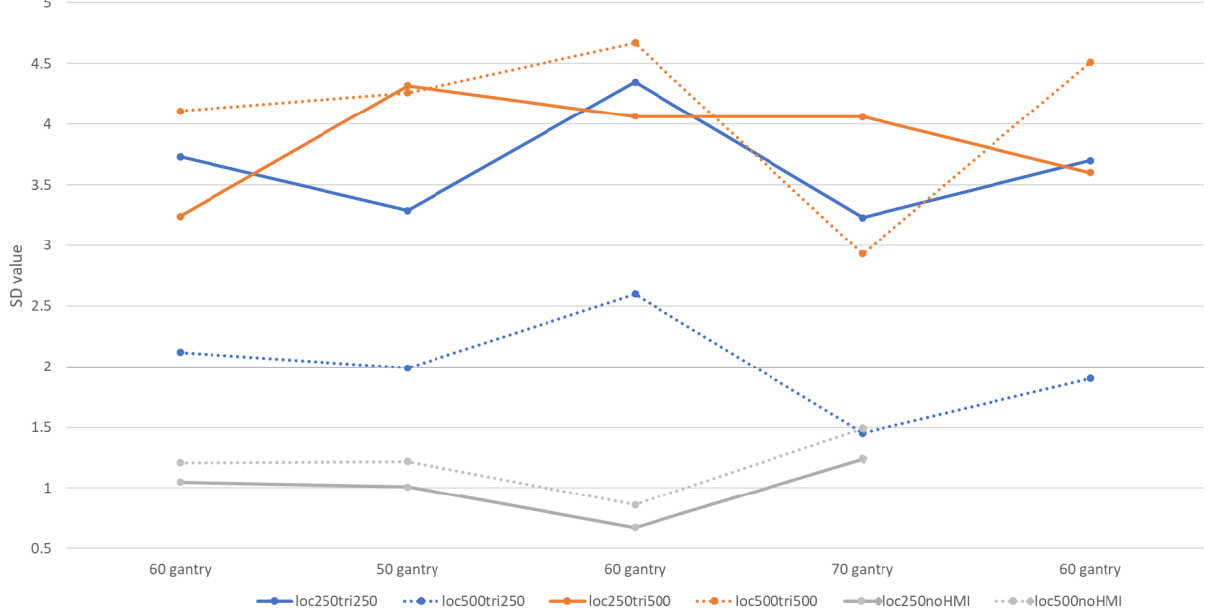
Figure 10. Graphical representation of the speed homogeneity (mph) in both experimental conditions. Plain lines represent the trig250 m and the noHMI conditions whereas dashed lines represent the trig500 m condition. Blues lines represent the trig250 m condition, orange lines the trig500 m condition and the grey lines the noHMI condition.